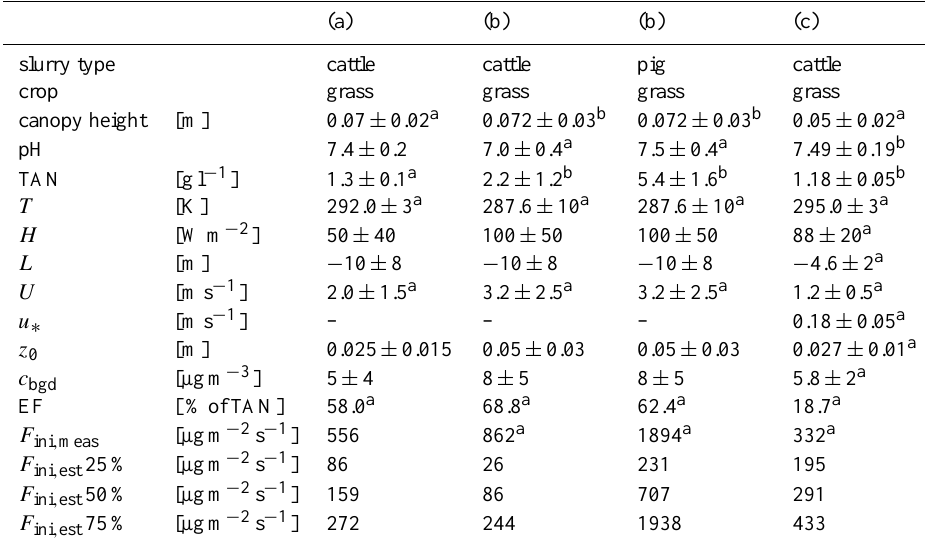
Table 2. Comparison of measured ( F ini , meas ) and (from slurry and atmospheric properties) estimated initial flux ( F ini , est ; 25, 50, and 75% denote median and quartiles of the F ini , est distribution) from slurry applied to grassland using splash plate; values derived from (a) Menzi et al. (1998)/Katz (1996), (b) Huijsmans et al. (2001), and (c) Sintermann et al.